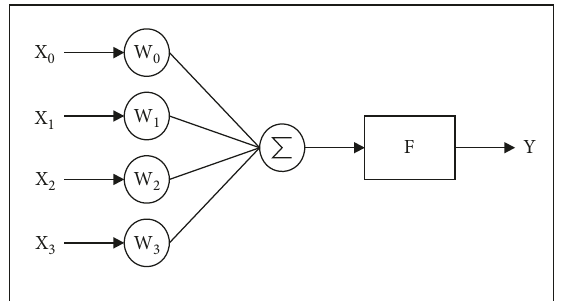
Figure 7: Neuro-fuzzy network structure [13].